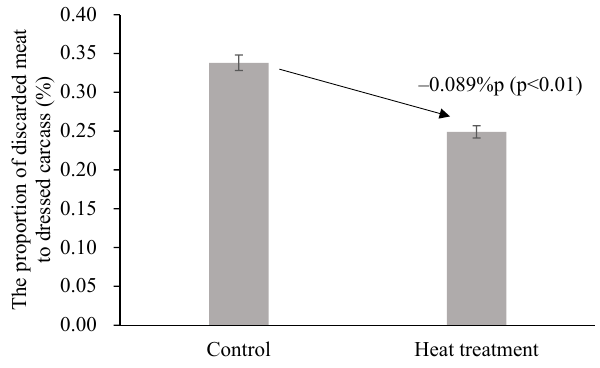
Figure 1. Incident rate of lesions at the injection site (pork butt) of foot-and-mouth disease vaccine after heat treatment at 40°C for 20 min. Error bars are standard error. 335